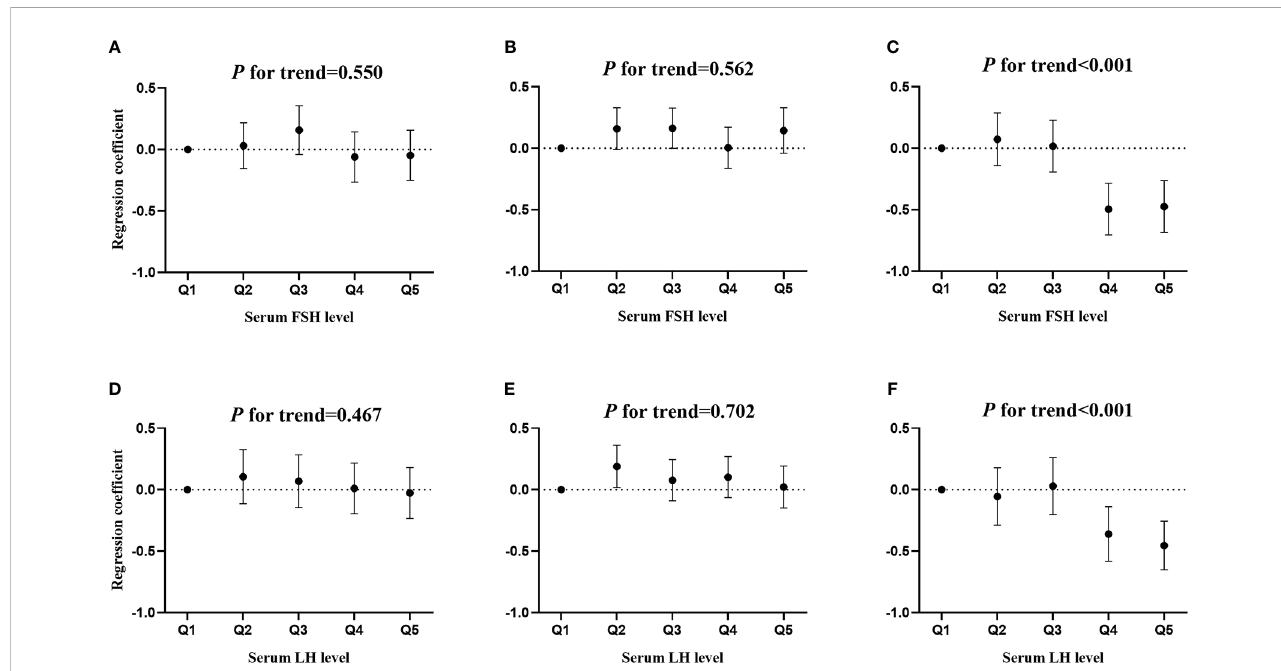
FIGURE 3 The associations of serum FSH and LH quintiles with MetS severity score. (A, D) premenopausal women, (B, E) perimenopausal women, and (C, F) postmenopausal women.